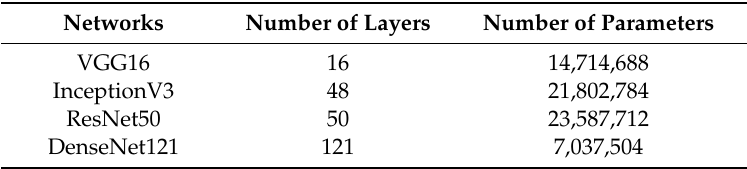
Table 1. Number of layers and parameters of the CNNs used in this study.